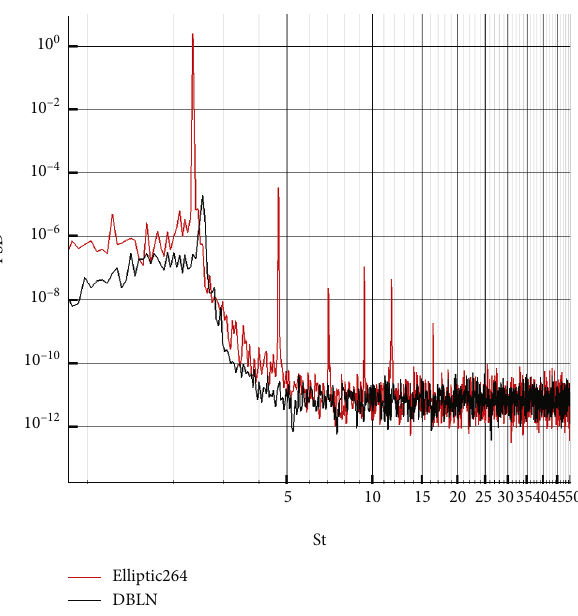
Figure 18: PSD of lift coe ffi cient ( Re = 0 : 8E6 , α = 0 °